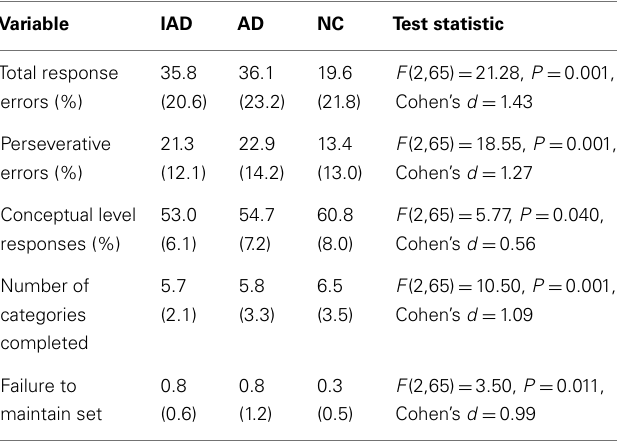
Table 4 |WSCT data [mean (SD)] in IAD group ( n = 22),AD group ( n = 22), and NC group ( n = 22)